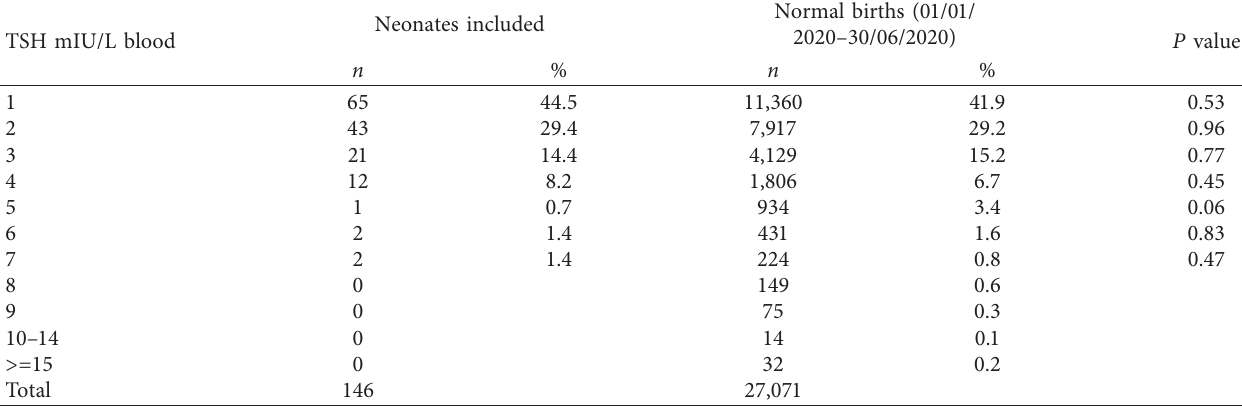
Table 2: TSH distribution of the neonates included compared to healthy neonates.